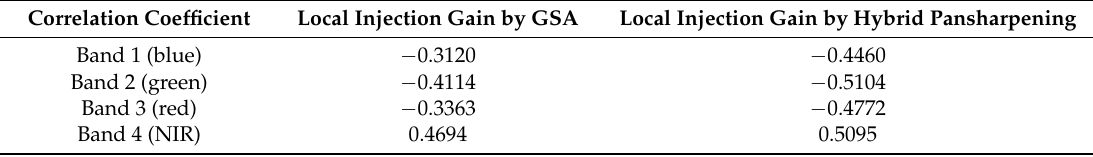
(cid:103) MS k , where (cid:101) P L indicates a panchromatic image with low spatial resolution to which the Starck